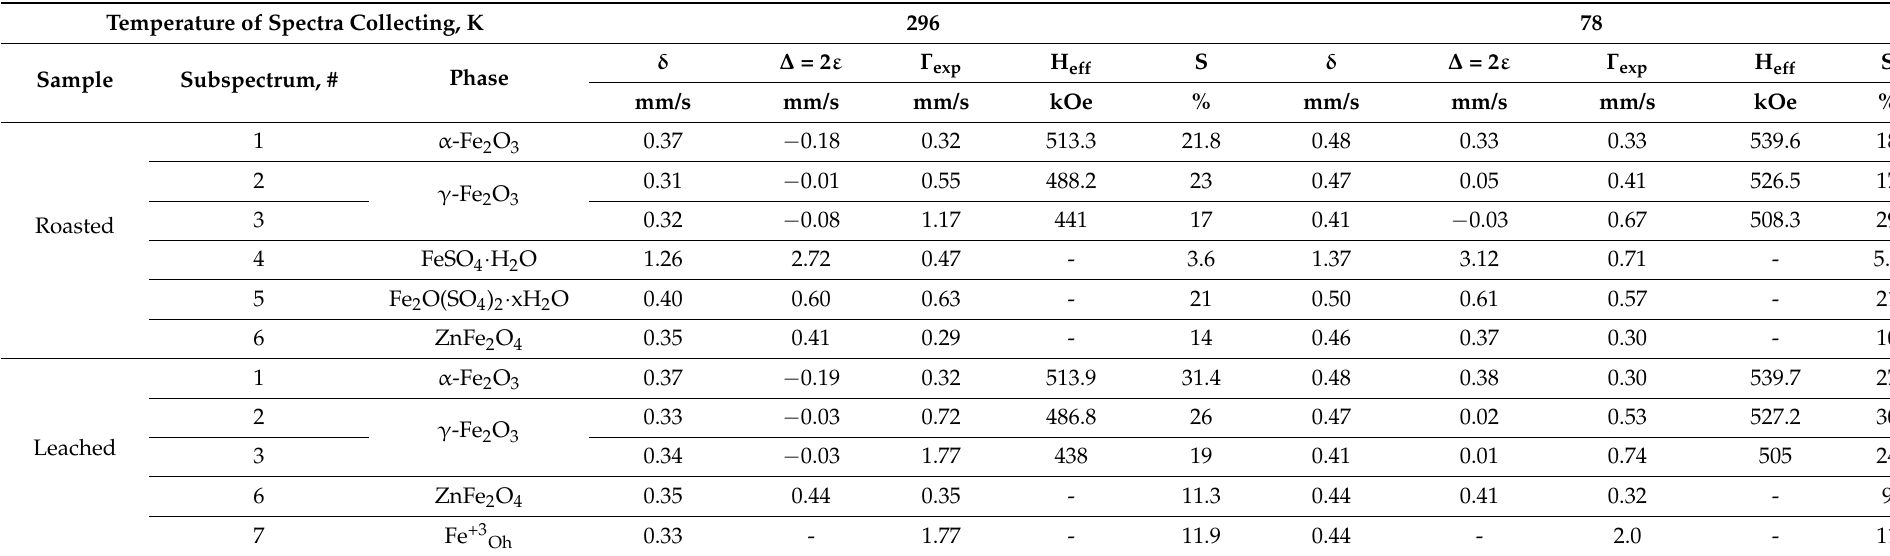
Table 8. Parameters 1 of the illustrated in Figure 14 Mössbauer spectra of ZPR roasted with the addition of 48% Fe 2 (SO 4 ) 3 · 9H 2 O during 180 min at 600 ◦ C, as well as of the same sample after water